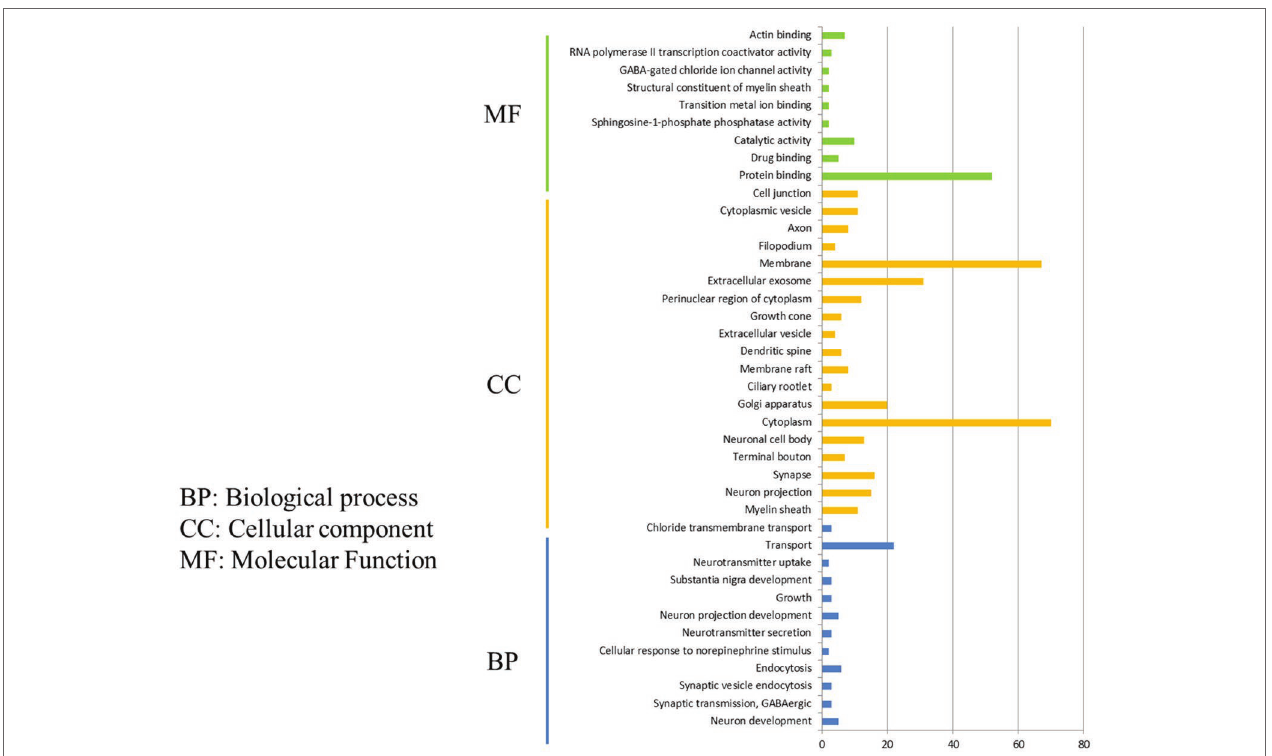
FIGURE 3 | Functional annotations and bioinformatic characterization of unique DEGs in P815 cells infected with H1N1 virus compared with H5N1 virus. The GO biological process terms, GO cellular component terms, and GO molecular function terms of unique DEGs in P815 cells infected with H1N1 virus and H5N1 virus were analyzed, respectively. Green bar chart represented biological classification of the IAV-regulated unique DEGs in P815 cells. Orange bar chart represented cellular classification of the IAV-regulated unique DEGs in P815 cells. Blue bar chart represented molecular classification of the IAV-regulated unique DEGs in P815